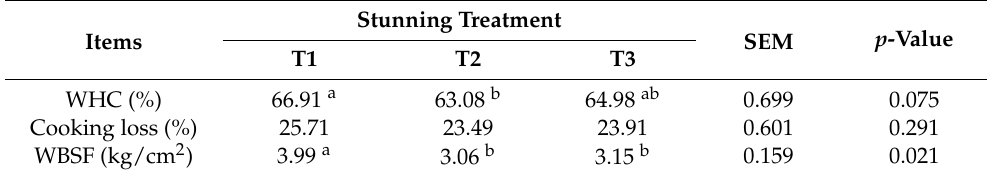
Table 3. Effect of electric and gas stunning (CO 2 -80% and N 2 -98%) on WHC, CL, and WBSF of pigs meat ( n = 7).